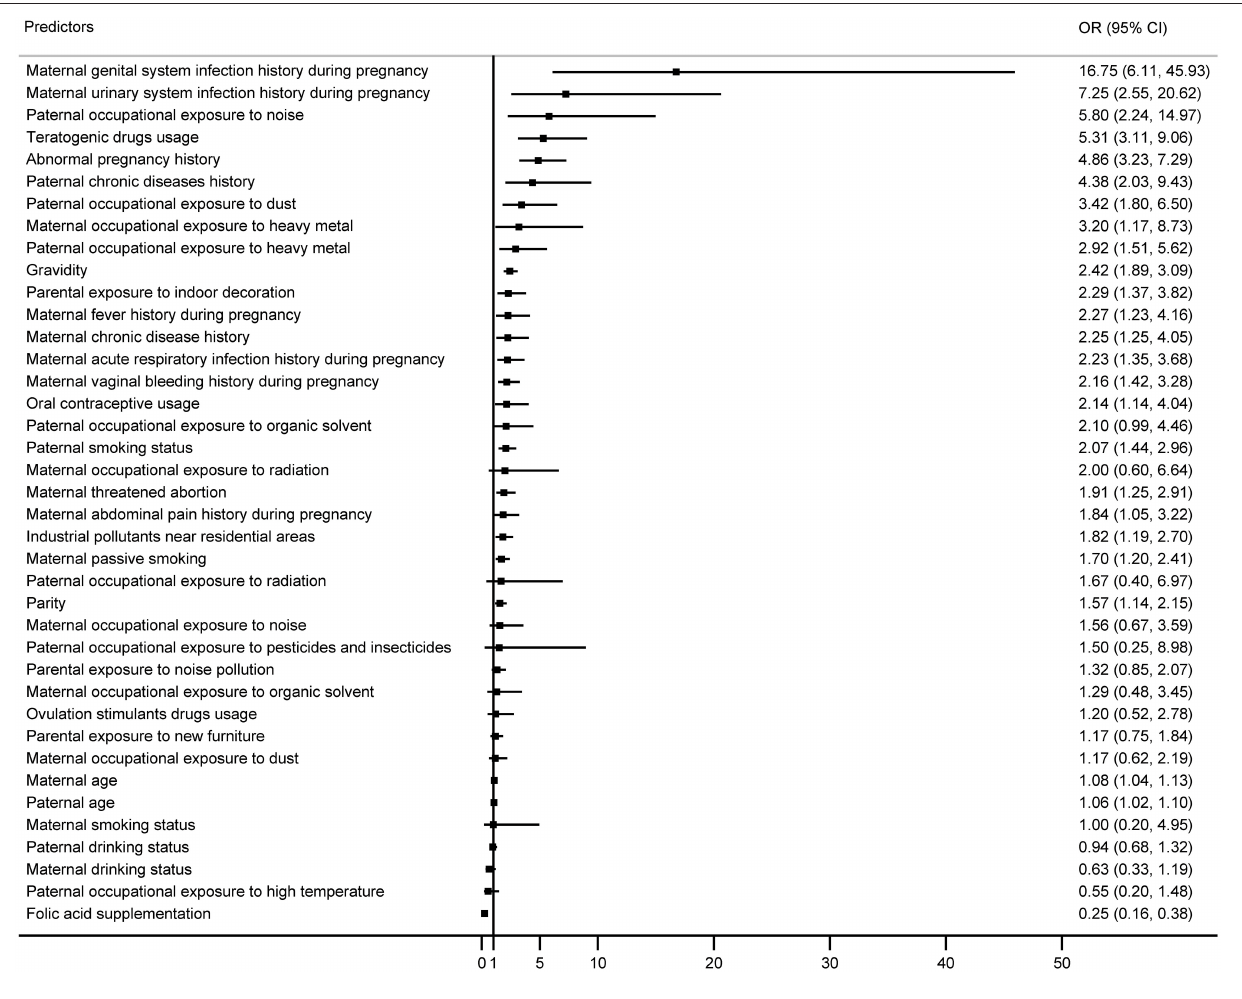
FIGURE 1 | ORs and 95% CIs for the association between each predictor and microtia according to conditional logistic regression model.